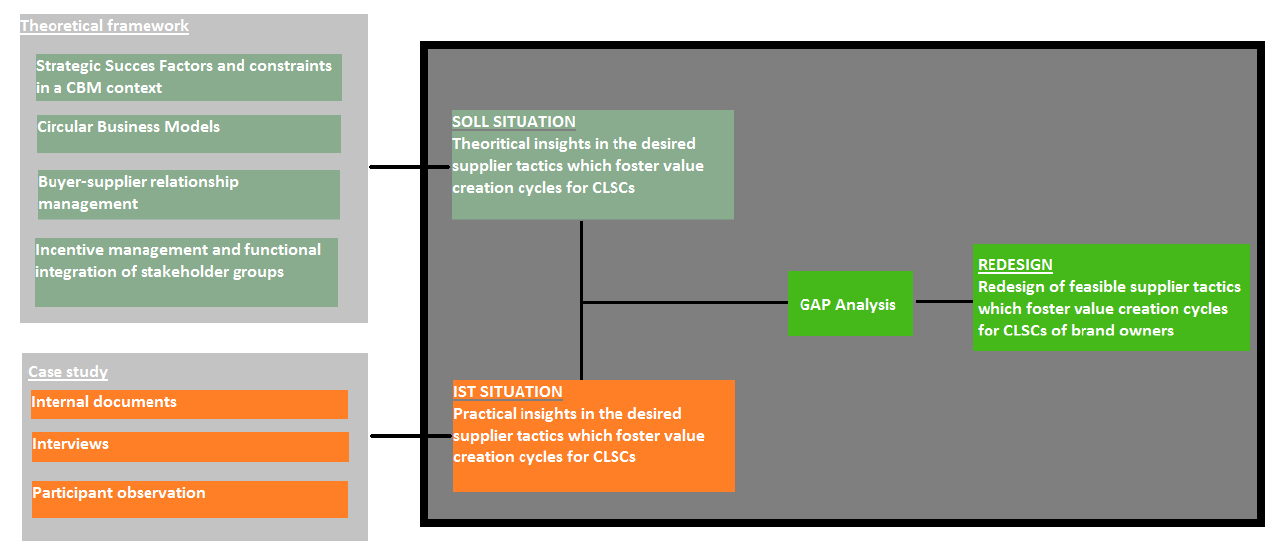
Figure 2. Research Figure 2. Research framework.